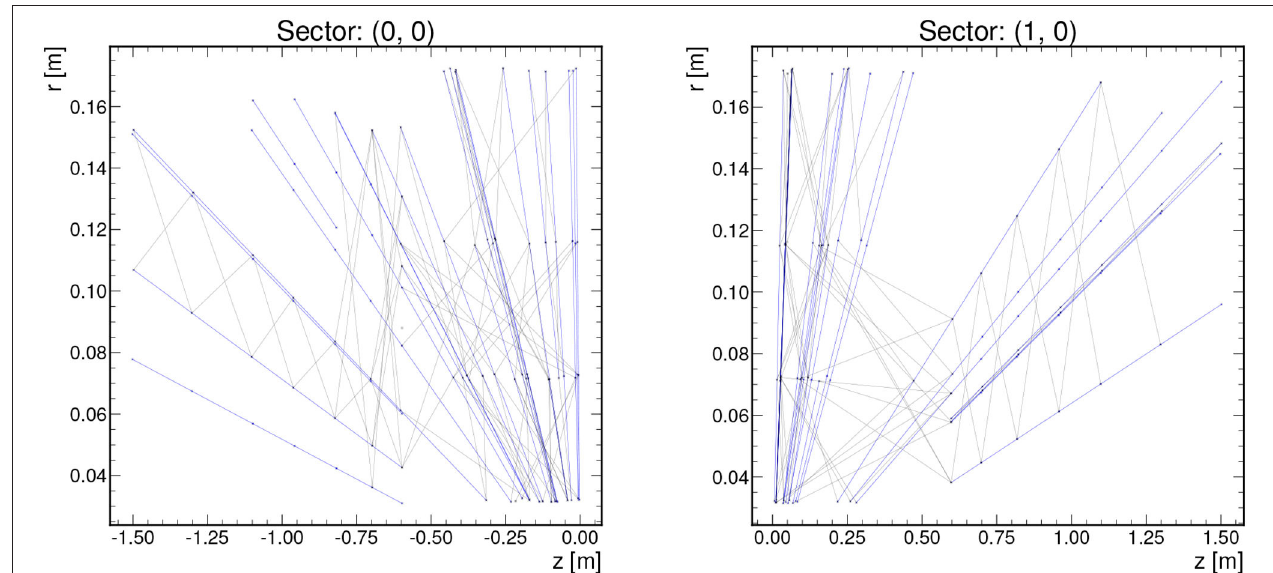
2GeV, z 0 < 15cm, 1φ/1 r < 0.0006, 8 φ sectors, and 2 η sectors. True track =